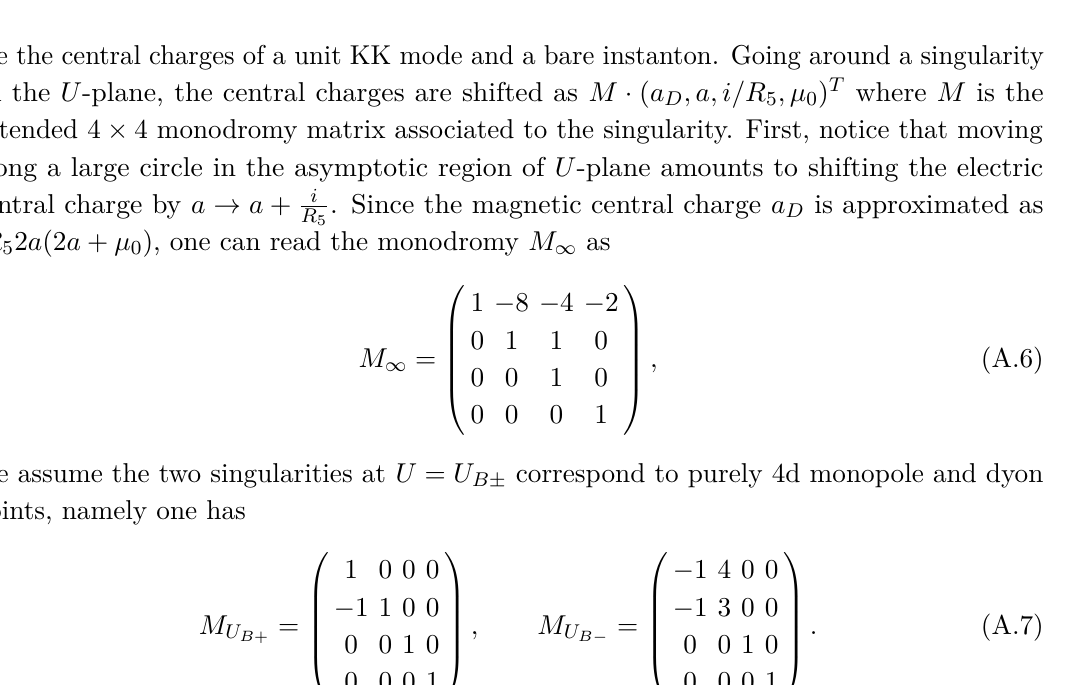
Figure 20 . The contours and monodromies on U-plane for SU(2) 0